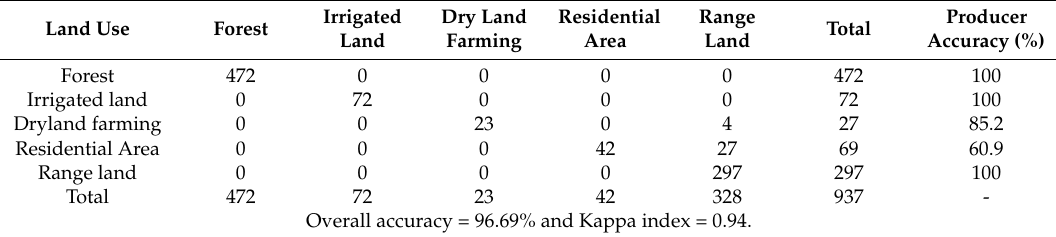
Table 3. Error matrix and accuracy assessment of the land use map for 1991.